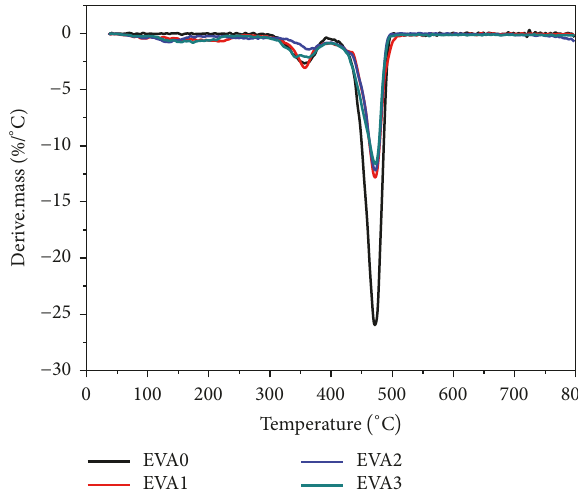
Figure 9: TG curves of EVA/LDHs composites. Figure 10: DTG curves of the EVA/LDHs